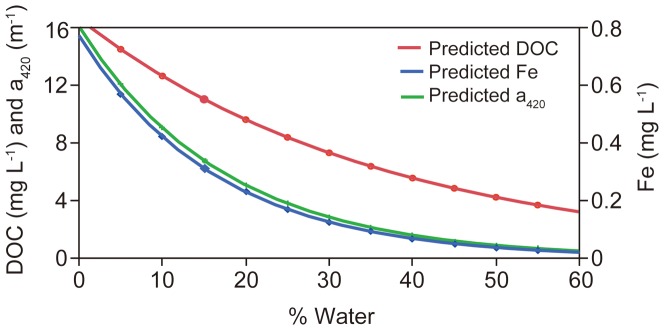
Decreasing iron (Fe), dissolved organic carbon (DOC) and absorbance (a420) with increasing percentage of lake surface area in the catchment area (% Water).The figure shows the predicted values of Fe, DOC and a420 from the simple exponential decay functions along the % Water gradient presented in Fig. 3. Fe and a420 decline equally fast with increasing % Water. The Fe and a420 decline is substantially faster than the decline of DOC. % Water can be seen as a proxy for water retention in the landscape (see methods).